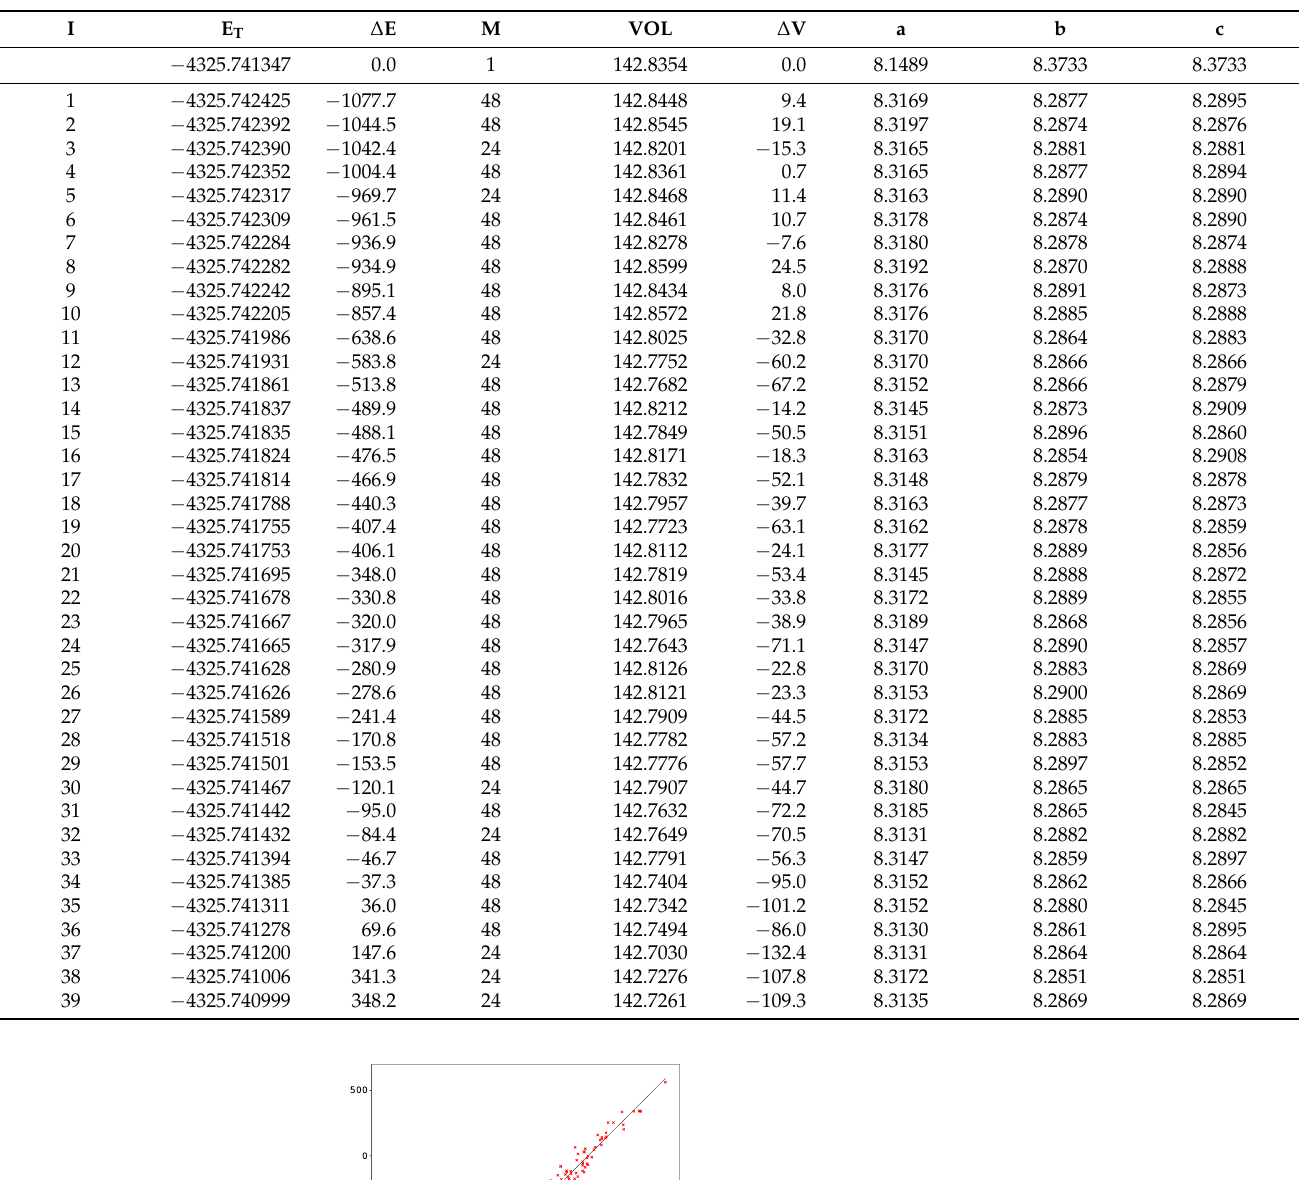
Table A7. As Table A6, for HSE06.